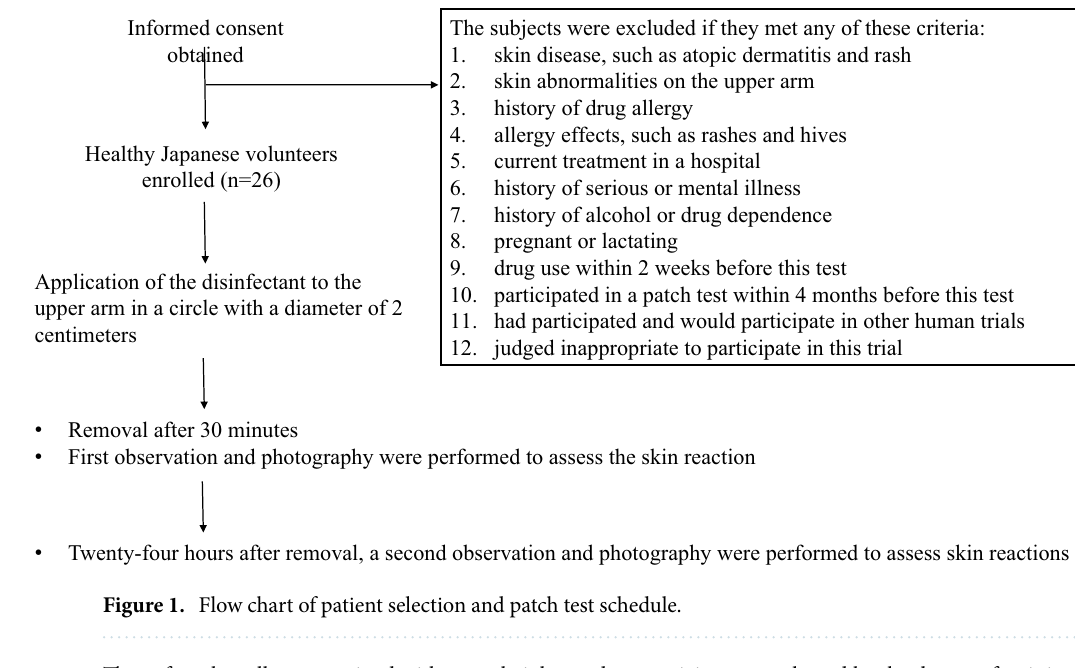
Figure 1. Flow chart of patient selection and patch test